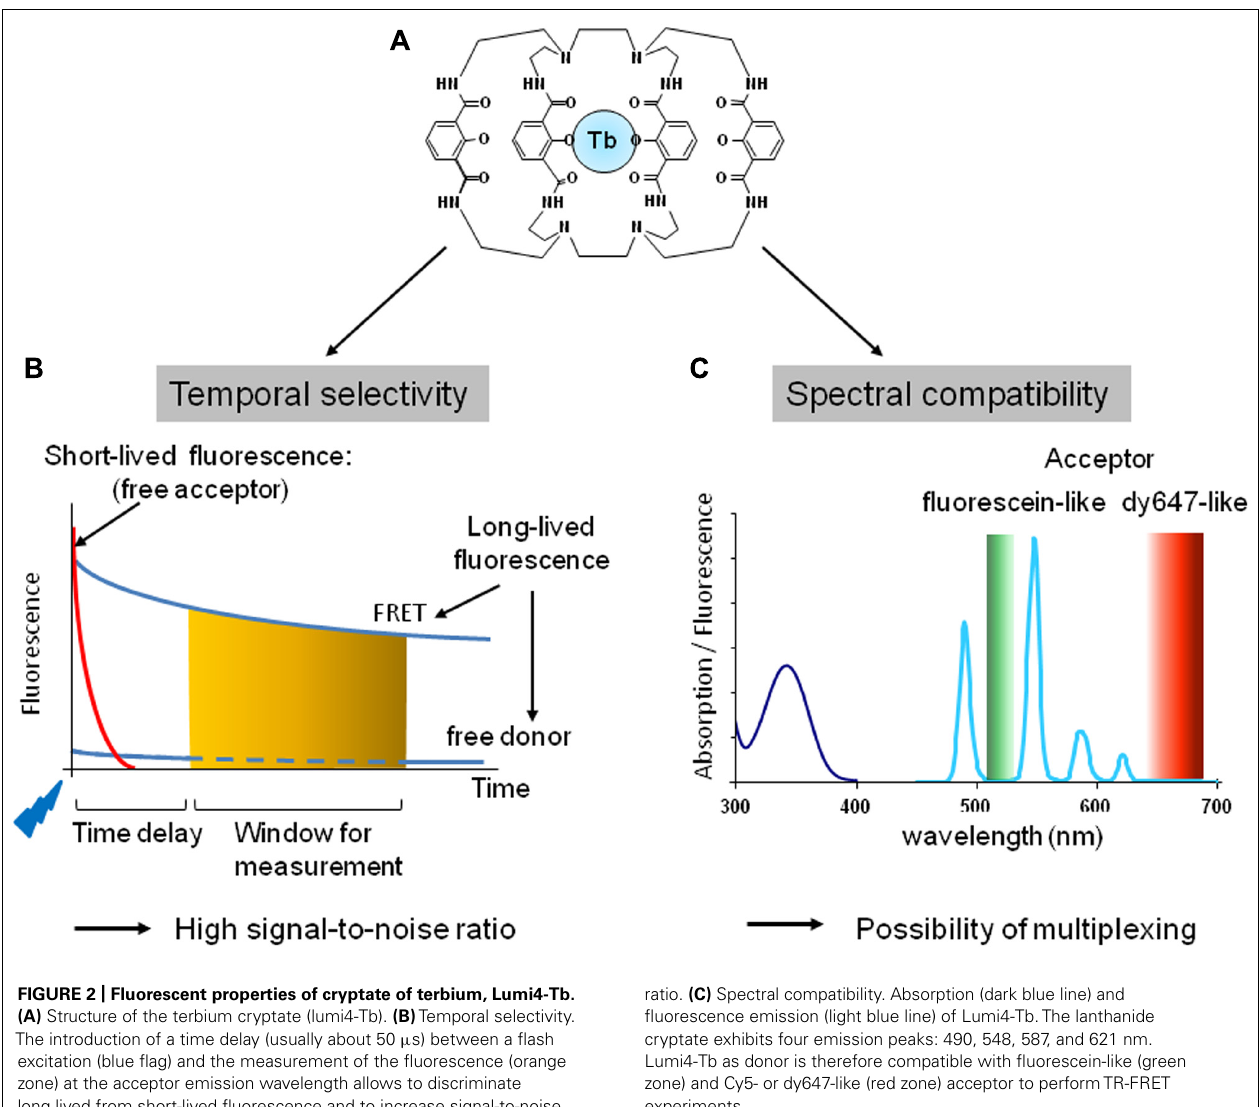
FIGURE 2 | Fluorescent properties of cryptate of terbium, Lumi4-Tb. (A) Structure of the terbium cryptate (lumi4-Tb). (B) Temporal selectivity. The introduction of a time delay (usually about 50 μ s) between a flash excitation (blue flag) and the measurement of the fluorescence (orange zone) at the acceptor emission wavelength allows to discriminate long lived from short-lived fluorescence and to increase signal-to-noise